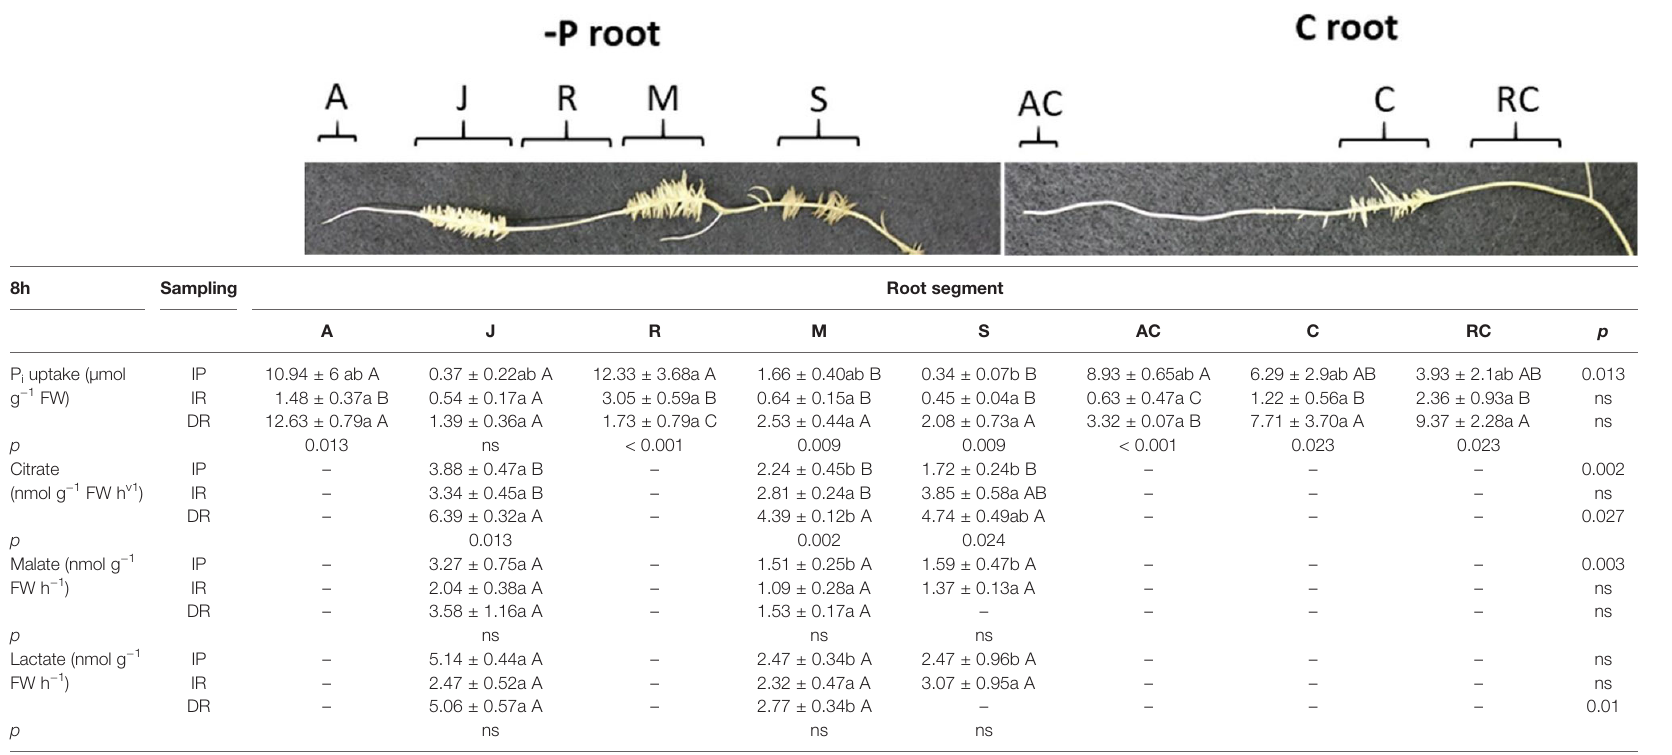
PhosphateuptakeratehasbeencalculatedbydifferencebetweentheconcentrationofPO 43- beforeandafterthecontacttimesofrootswiththeuptakesolution.-Prootshavebeenseparatedin5differentrootsegments:A=apex,J=juvenile clusterroot,R=root,M=matureclusterroot,S=senescentclusterroot.Crootshavebeenseparatedin3differentrootsegments:AC=apexcontrol,C=clustercontrol,RC=rootcontrol.Phosphateuptakeandcarboxylateexudationhave beendeterminedusingthreedifferentroothandlings:IP=intactplants,IR=intactroots,DR=dissectedroots.Dataarepresentedasmean±SE,n=5.Lowercaselettersindicatestatisticalsigni fi cancebetweendifferentrootsegments(i.e.A vs J) within the same root handling method according to one-way ANOVA comparing means by Holm-Sidak post hoc test with a signi fi cance threshold at p < 0.05. Upper case letters indicate statistical signi fi cance within the same root segment but different sampling methods (i.e. IP vs IR) according to one-way ANOVA comparing means by Holm-Sidak post hoc test with a signi fi cance threshold at p < 0.05; ns = non-signi fi